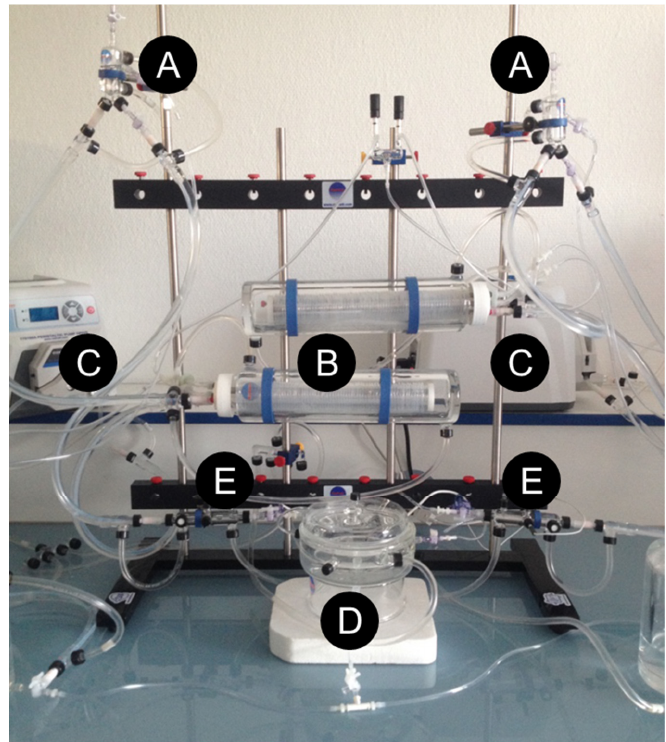
Figure 6. Experimental ex vivo machine perfusion system. Ex vivo machine perfusion system is adapted from liver/kidney systems. (A) Bubble trap. (B) Membrane oxygenating. (D) Liver perfu- sion chamber (Radnoti LLC, Covina, CA, USA), assembled by the authors (N.A.-F. and A.L.). (C) Peristaltic pump (MasterFlex ® , Thermo Fisher Scientific, Waltham, MA, USA). (E) Flow sensor (TS410 Tubing Module, Transonic Systems Inc., Ithaca, NY, USA), a water bath circulator pump (9102A12E, 6 L High-Stability Digital Controller Refrigerated/Heated Circulating Bath, Polyscience, Niles, IL, USA) and an oxygen bottle (95% O2/5% CO 2 , Air Liquide, Paris, France) . A total of 36 animals were randomly assigned to the following 3 experimental groups: (1) control group ( n = 12 livers), immediately perfused in the ex vivo system at 37 °C for direct evaluation; (2) SCS-24H group ( n = 12 livers), preserved for 24 h in preserva- tion solution (PS) under static cold storage (SCS) alone before 2 h of normothermia ma- chine perfusion (NMP) evaluation at 37 °C, as the current gold standard; (3) SCS-24H + M101 group ( n = 12), where the PS was supplemented with M101 and the livers were preserved and evaluated using the same procedure as the former group (Figure 2). Per- fusate and tissue samples were taken during and after the experiments, frozen in liquid nitrogen and kept at − 80 °C for further analysis (Figure 7).